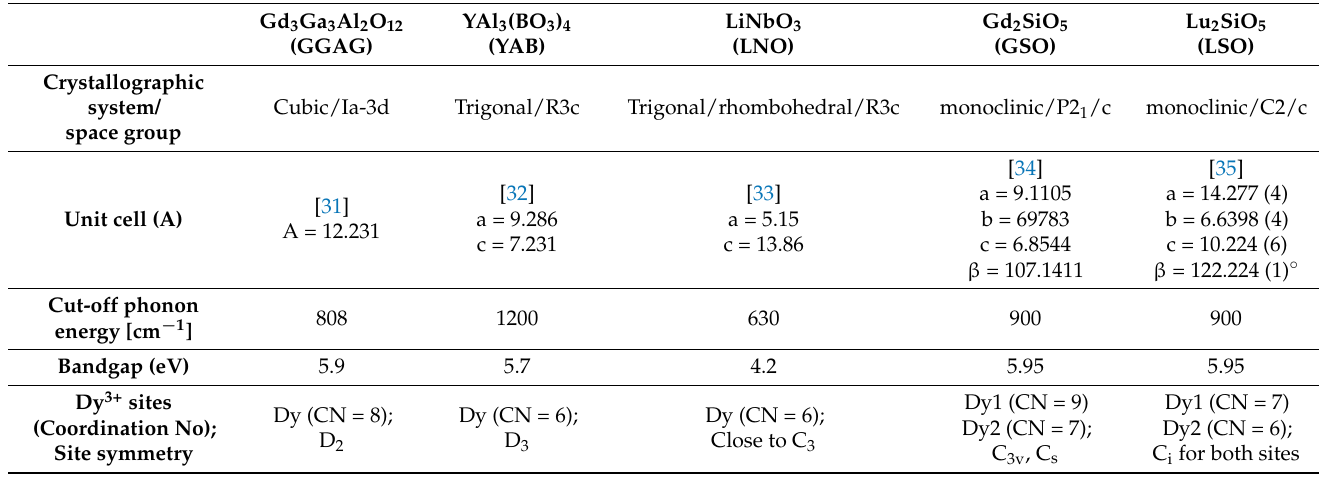
Table 1. Selected structural and optical features of the crystals under